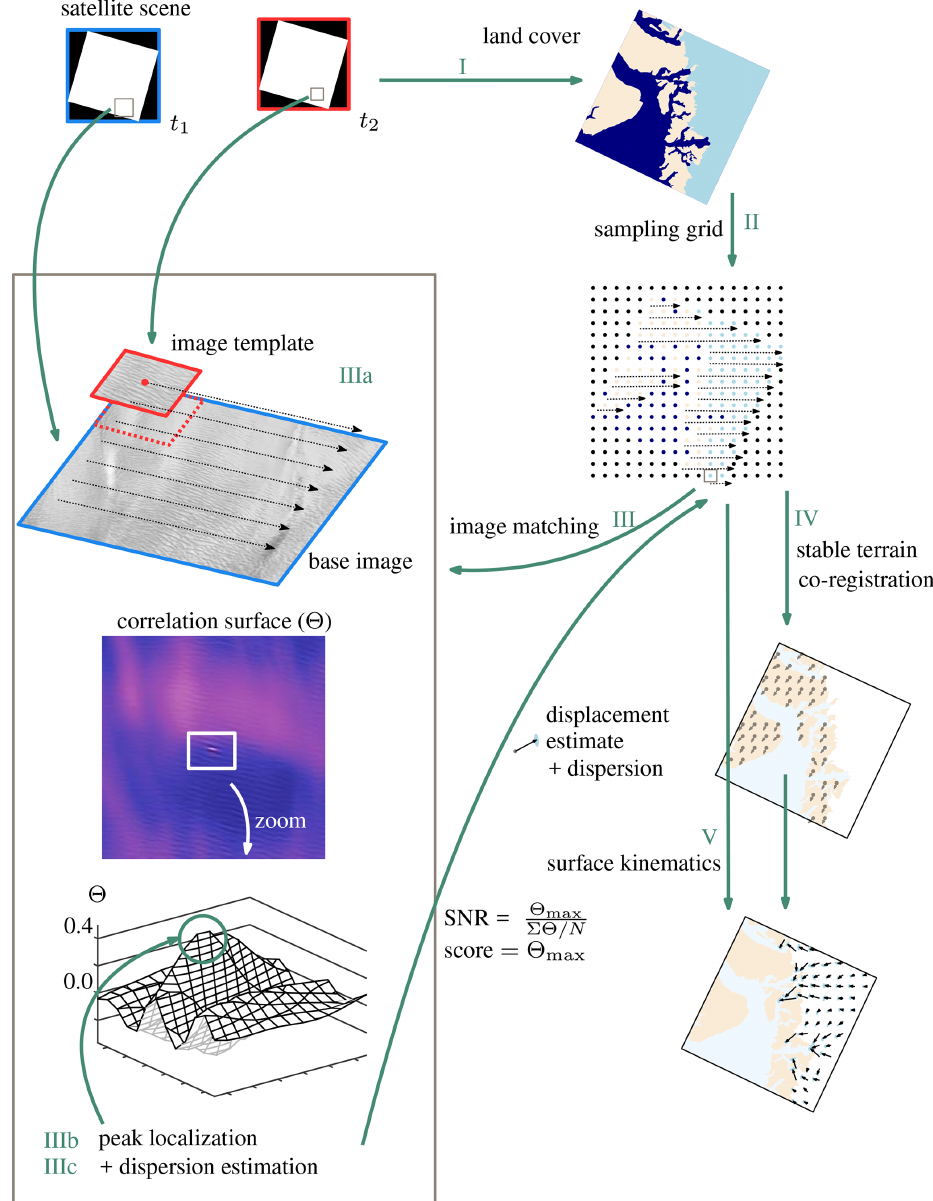
Figure A1. Schematic of the main procedure to generate a displacement field from a pair of remote sensing images.